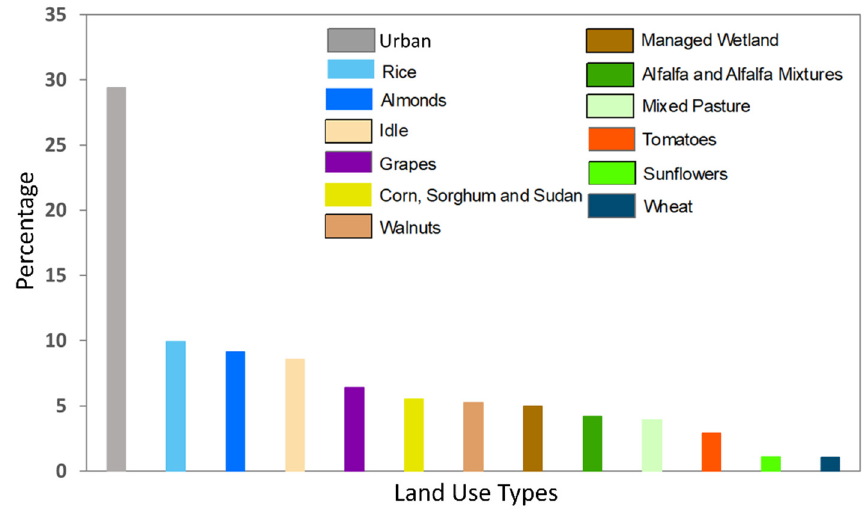
Figure 3. Percentage of major land use types in the study area based on the 2014 land use data.